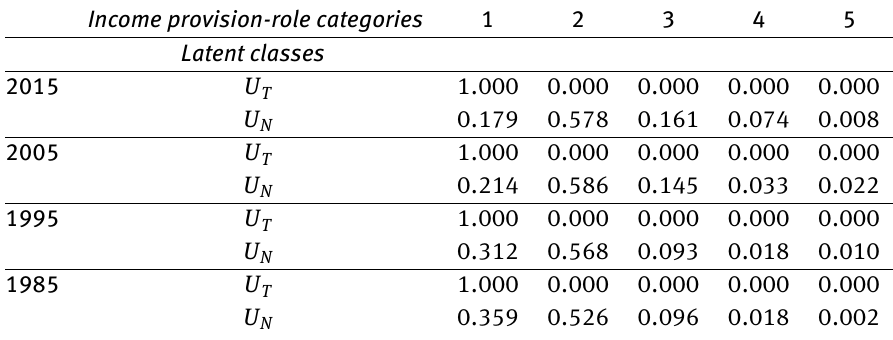
Table 5: Estimated conditional probabilities of the responses given the latent classes ( ˆ ϕ j | u ) under the selected model for each year ( U T for latent class labeled as traditional couples and U N for new couples, categories are defined in Table